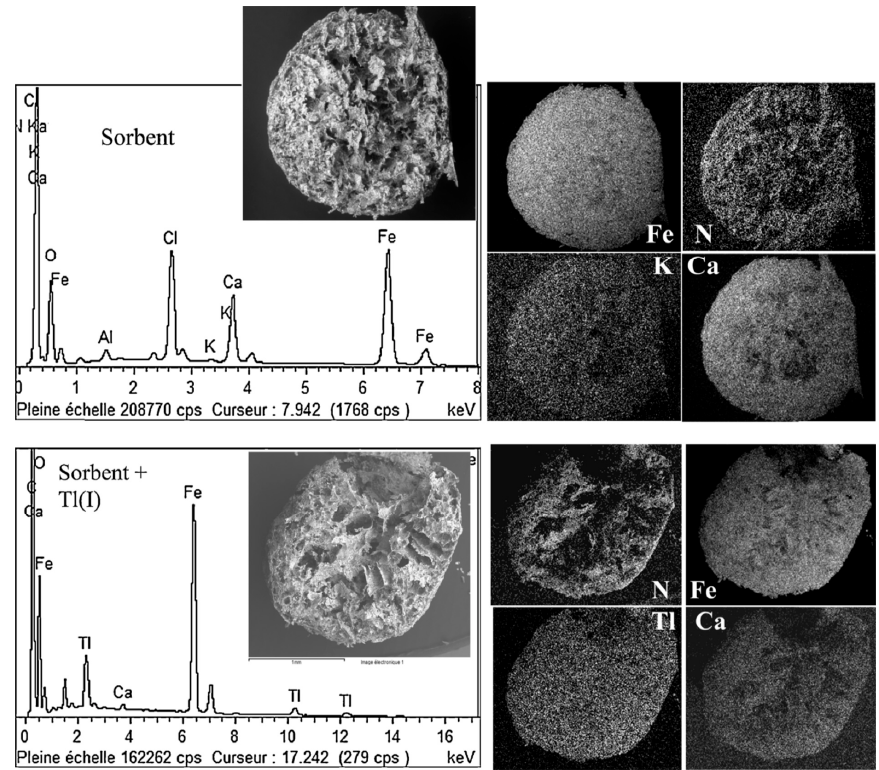
Figure 3. SEM-EDX analyses of cross-sections of hybrid Prussian Blue/alginate capsules before and after Tl(I) sorption (reprinted with permission from Elsevier [164]).